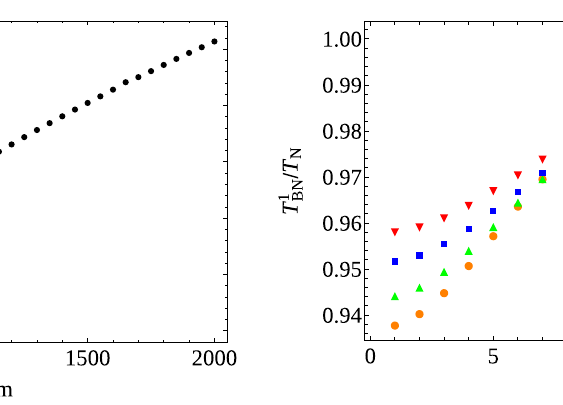
Fig. 5 Left panel: Relative difference between T 1 tion of the initial distance r 0 for m P = 1 . 4 × 10 − 4 g. The initial angular velocity ˙ θ 0 has been optimized for each r 0 so as to maximize R 1